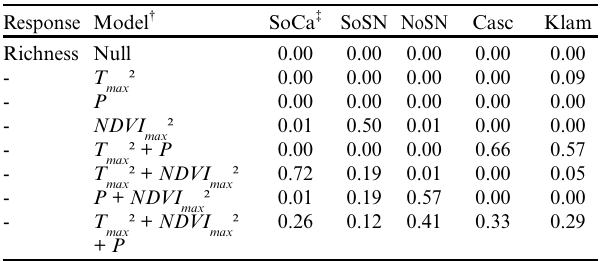
Table 2 . Individual model AIC weights, by region, for additive and single-variable models testing the ability of different environmental hypotheses to explain observed avian richness.